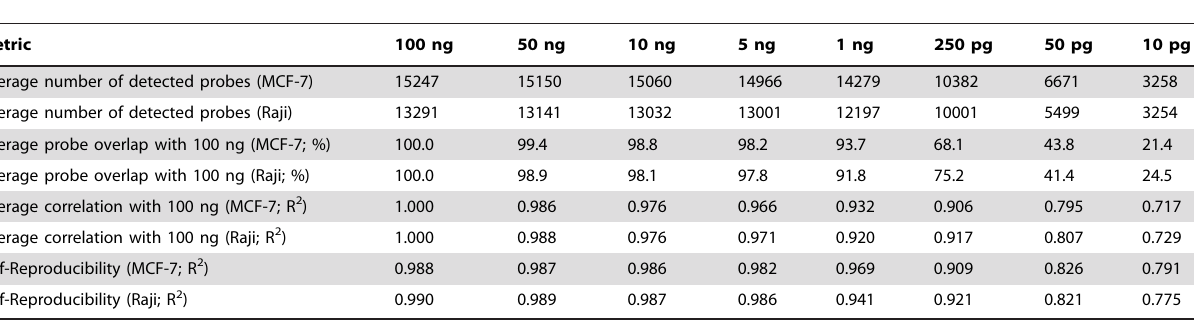
Table 3. WG-DASL Assay Performance as a Function of Intact RNA